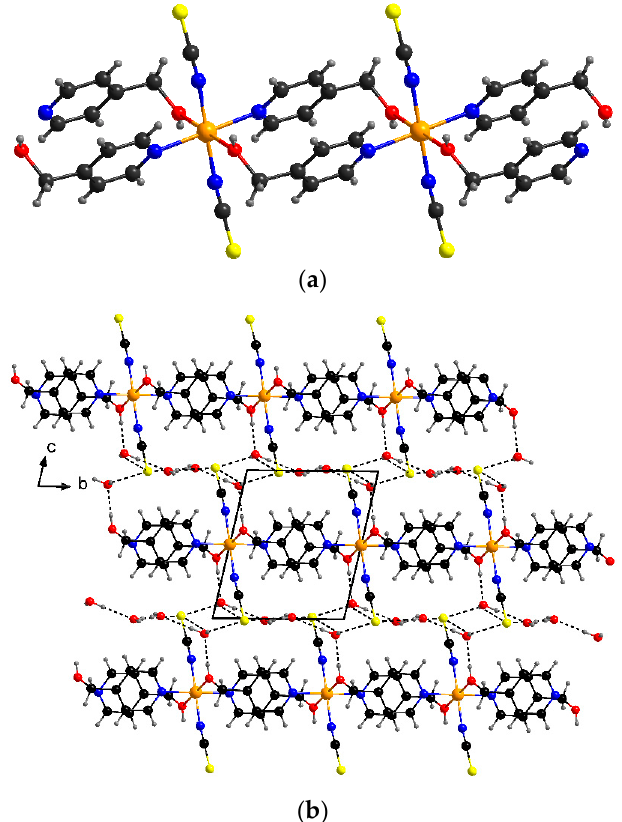
Figure 4. Crystal structure of 4 with view of the chain ( a ) and with view along the crystallographic a axis ( b ). Intermolecular hydrogen bonding shown as dashed lines and an ORTEP plot is shown in Figure S6 in the Supplementary Material.